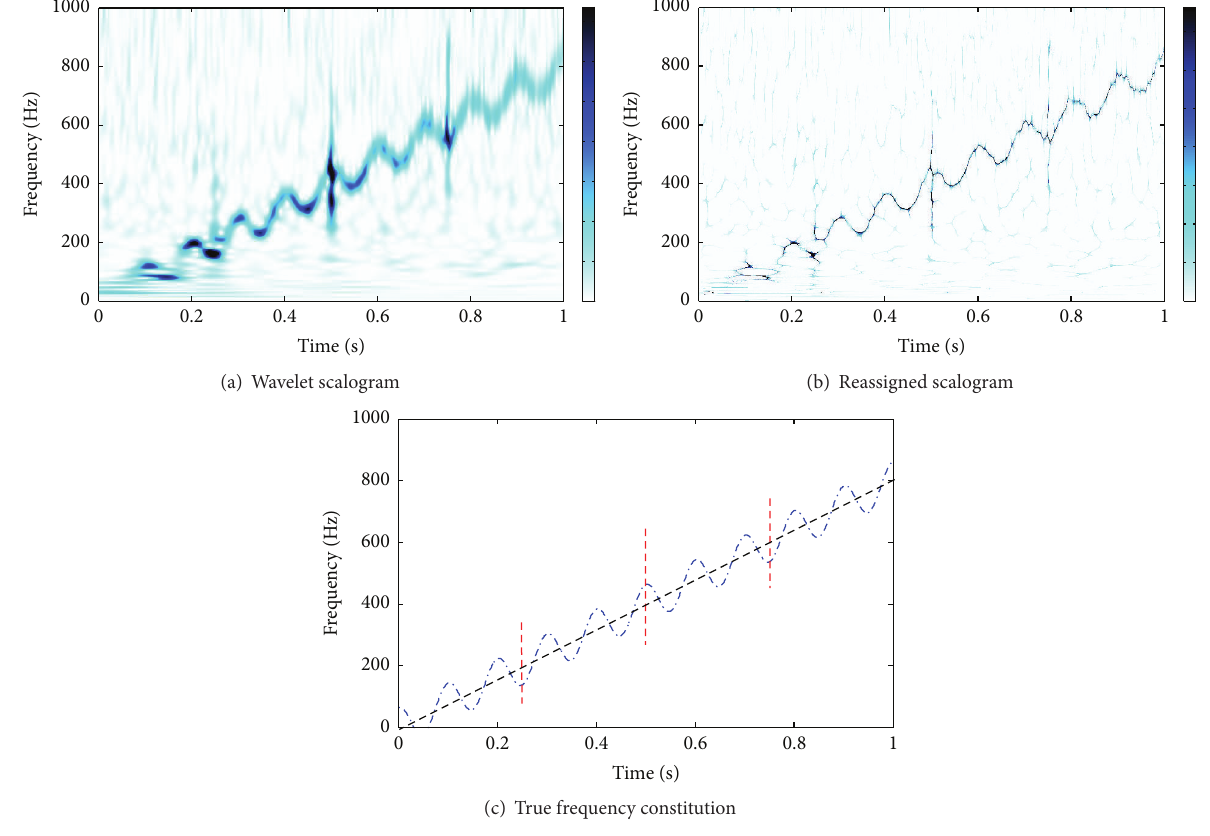
Figure 2: TFRs of the simulated signal.